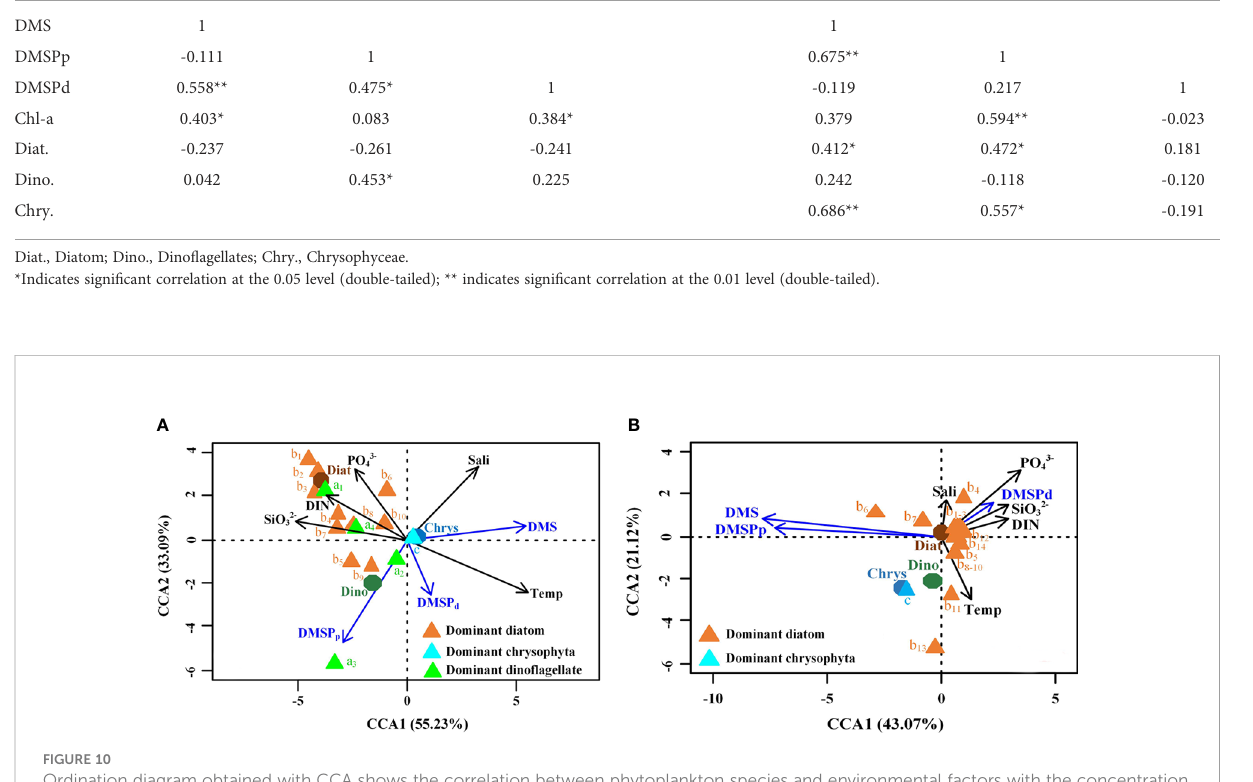
FIGURE 10 Ordination diagram obtained with CCA shows the correlation between phytoplankton species and environmental factors with the concentration of DMS and DMSP. A, B, and C represent dino fl agellates, diatoms, and Chrysophyceae, respectively, in (A) summer and (B) autumn.